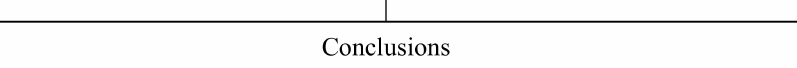
Figure 4. A flowchart of our